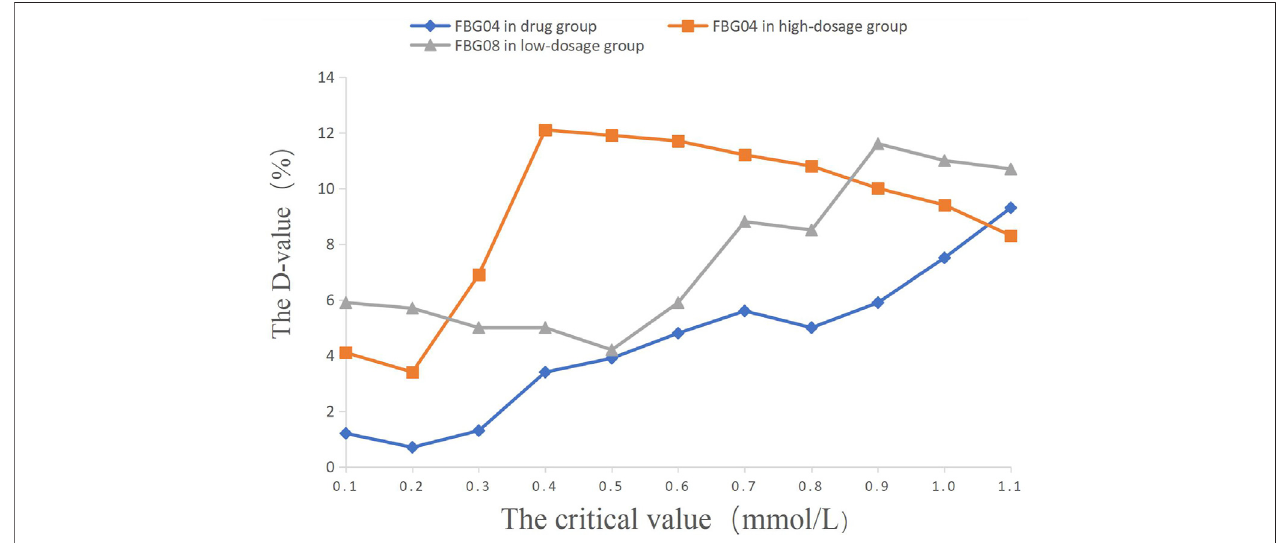
FIGURE 4 | The percentage of ef fi cacy in study 2. The Y-axis represents the Difference value (D-value) between the percentage of ef fi cacy and 85%.